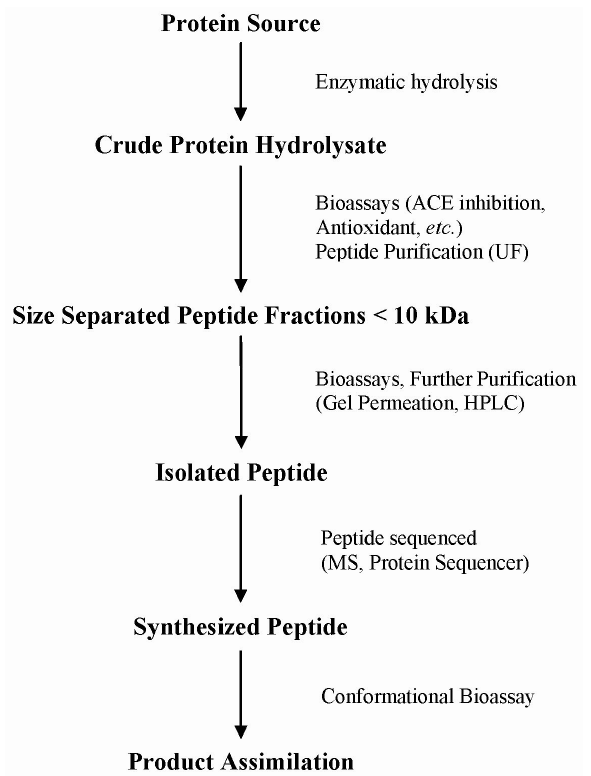
Figure 1. Procedure for the isolation and identification of bioactive peptides from food proteins, adapted from Arihara & Ohata